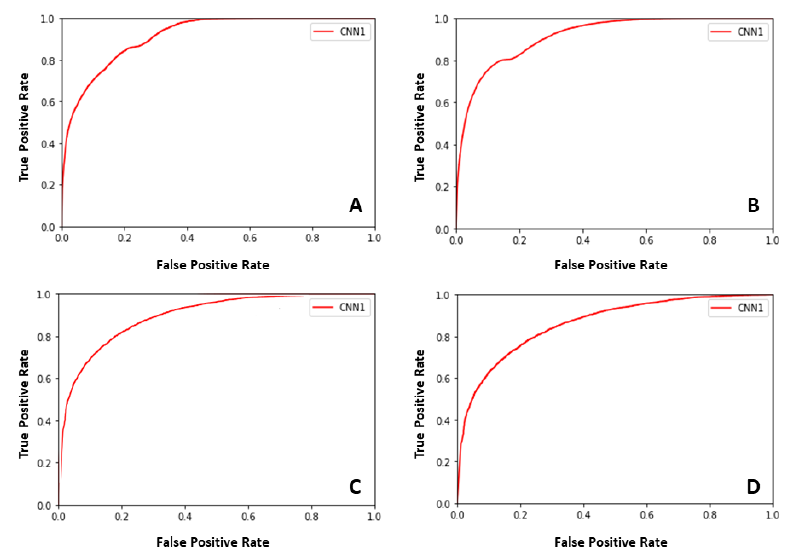
Figure 6. The receiver operating characteristic (ROC) curves for the proposed framework of the first level (100 × 100). CNN1 ( A ), CNN2 ( B ), CNN3 ( C ), and CNN4 ( D ).